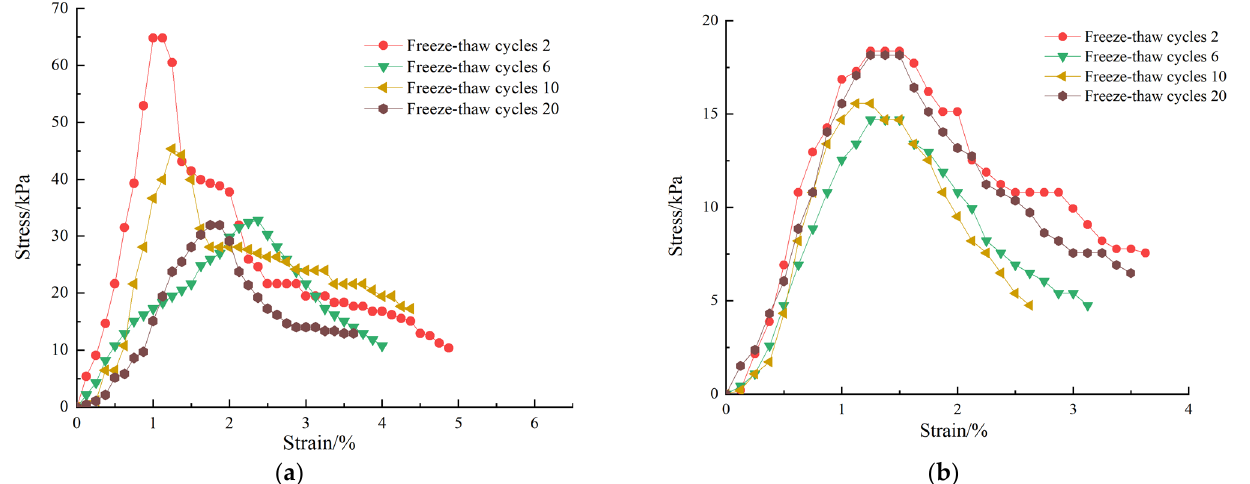
Figure 11. Stress–strain curves of loess with different freeze–thaw cycles. ( a ) Undisturbed loess. ( b ) Remolded loess.